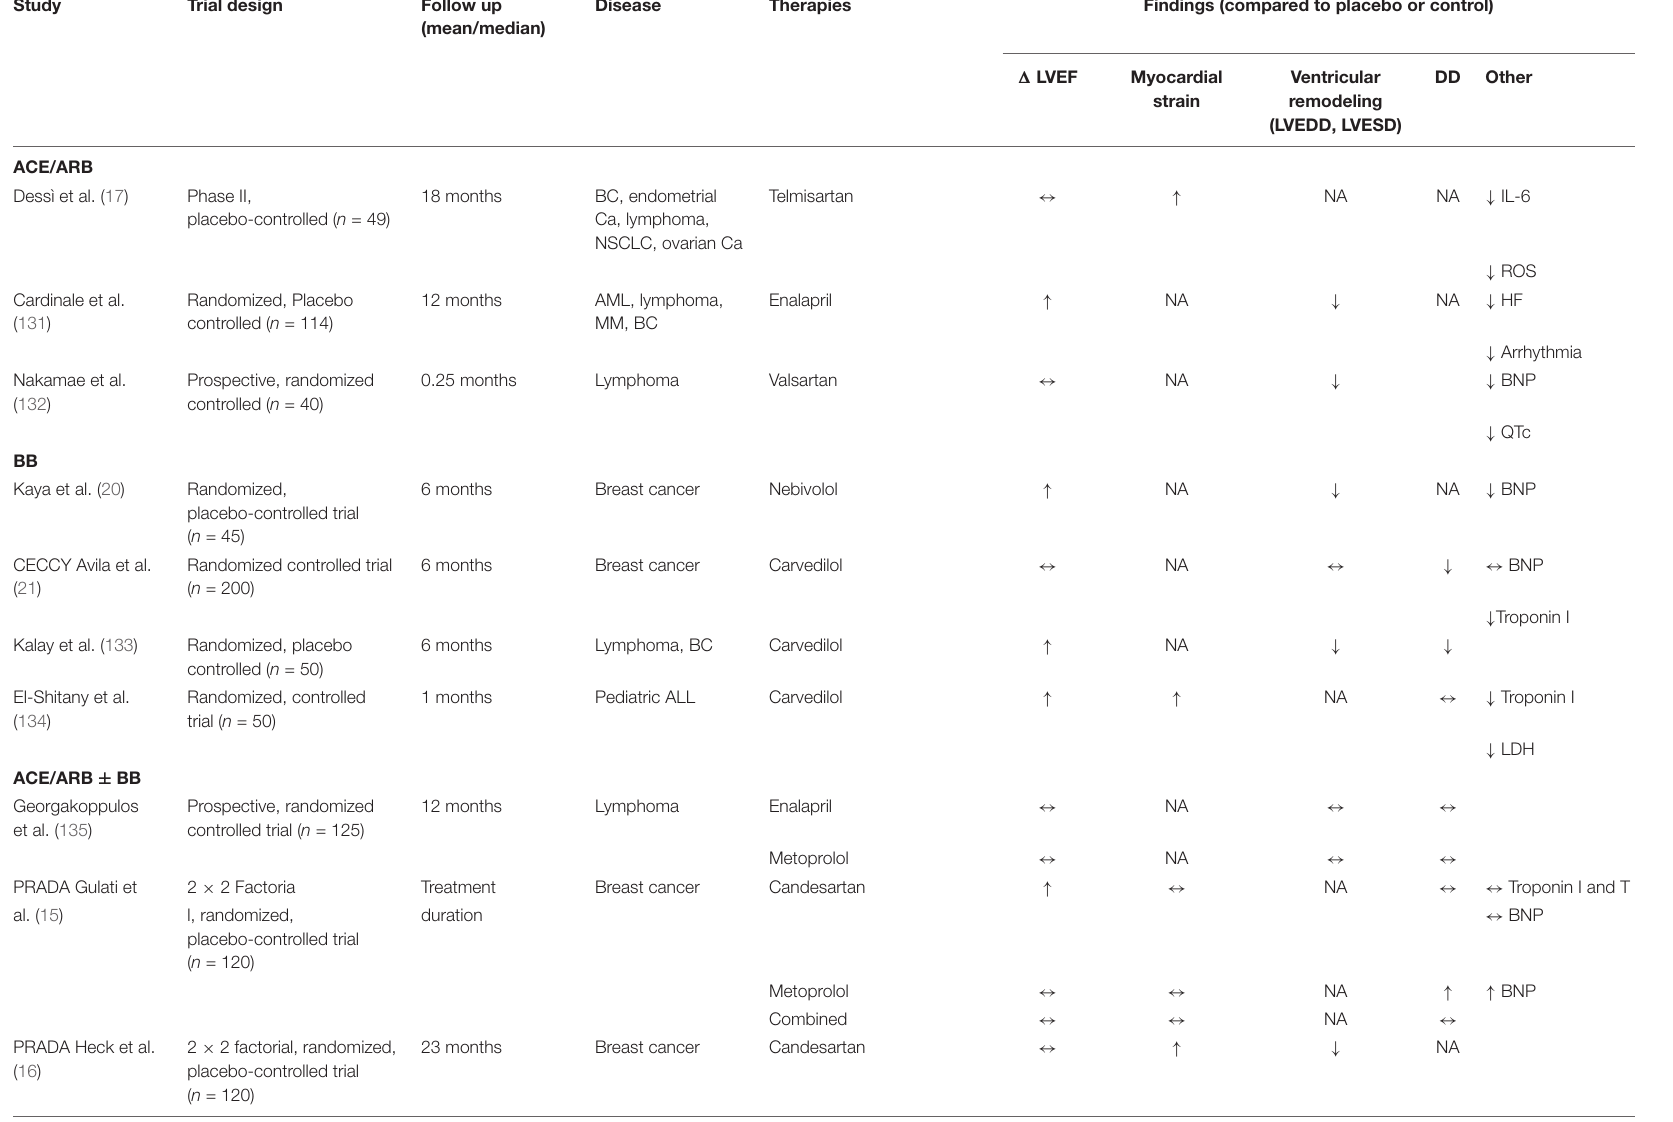
TABLE 2 | Summary of results from clinical studies for anthracycline induced cardiotoxicity therapies.